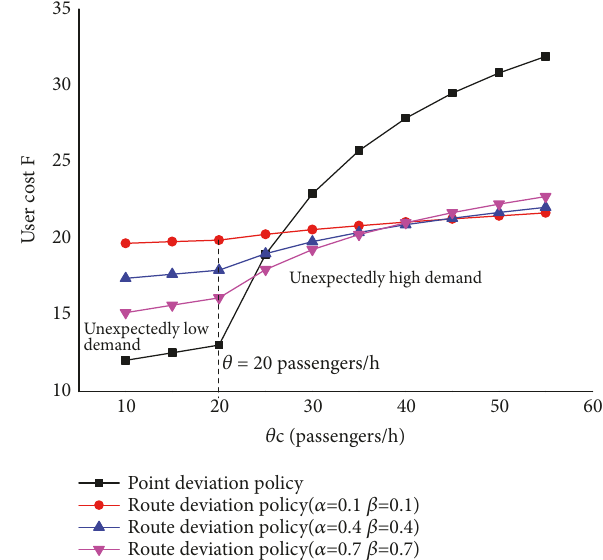
Figure 5: Comparison of system performance at unexpected demand